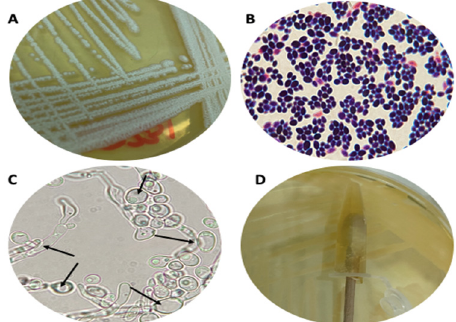
Figure 2. Culture and purity verification of Candida ATCC 90030 strain as representative of the strains used in the present work. ( A ) Yeast culture on Sabouraud agar; ( B ) Gram-stain of yeast cells; ( C ) Wet mount of yeast cells obtained from pure cultures. Note the vacuoles of yeast cells (black arrows) lacking BLBs; ( D ) Urease test performed on yeast cultures. BLBs: bacteria-like bodies.